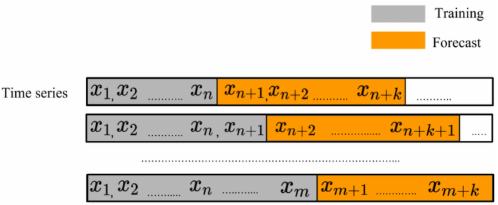
Figure 6. Time series transformation for LSTM models